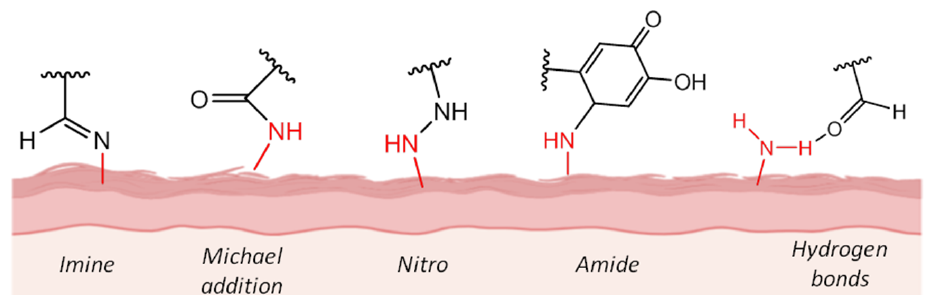
Figure 2. Intermolecular interactions between polymer chains and